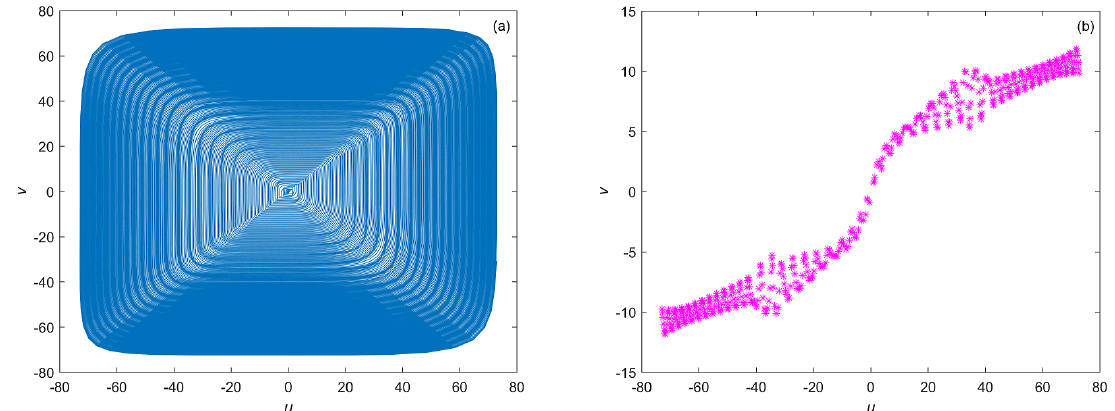
Figure 4. ( a ) The chaotic attractor in the u - v plane; ( b ) The Poincaré mapping on the section p = 0.